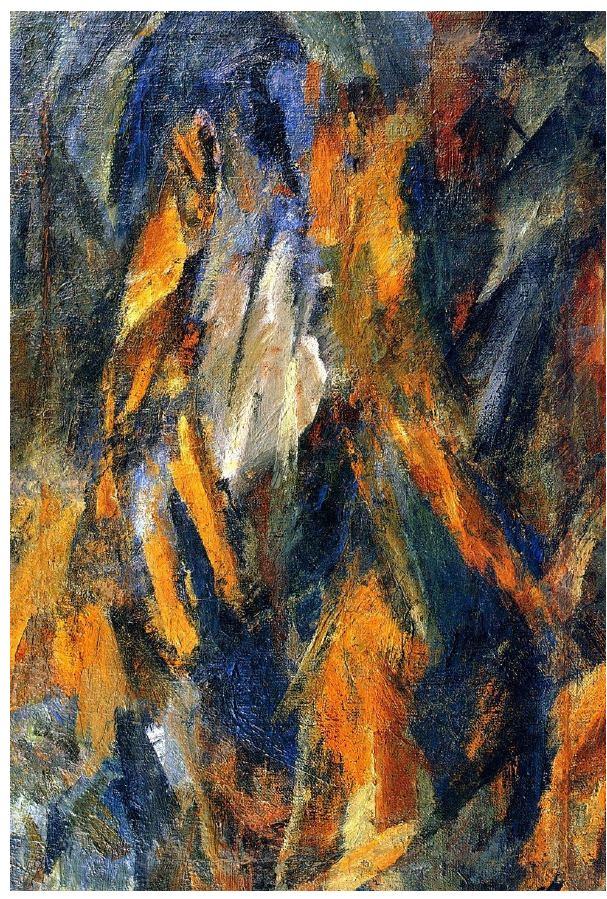
Figure 5. Vasily Chekrygin, The Transformation of Flesh into Spirit (Agonising) , 1913, oil on canvas, collection of S.I. Grigoryants, Moscow.